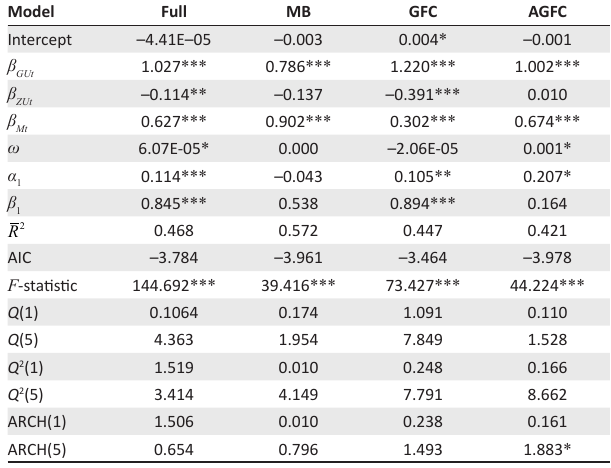
TABLE 6: GARCH(1,1) model results.